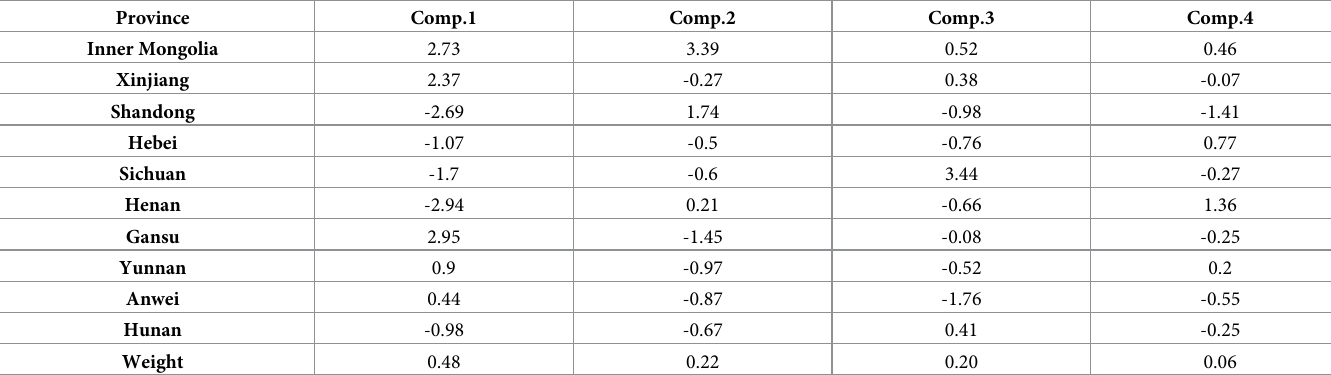
Table 4. Principal component analysis results and corresponding weights.